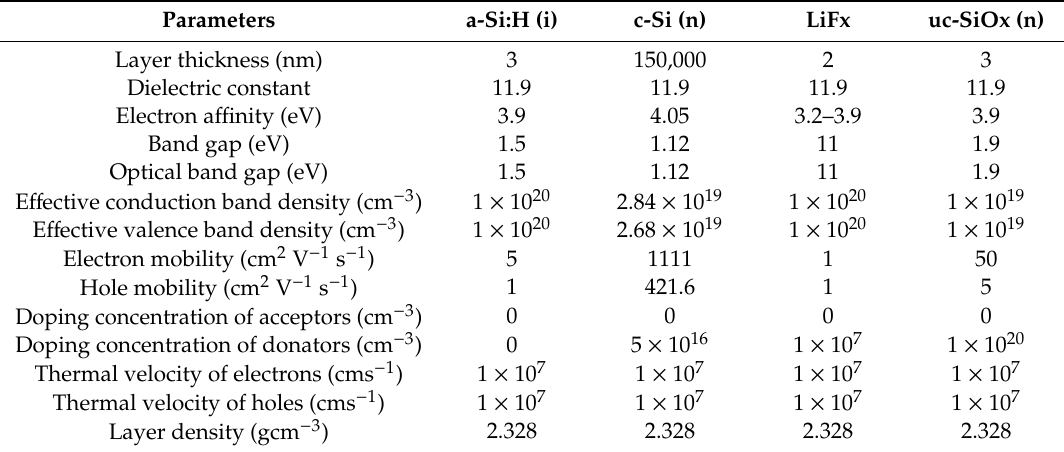
Table 1. Simulation parameters for LiF x and various silicon layers in an electron-based carrier selective contact (CSC) solar